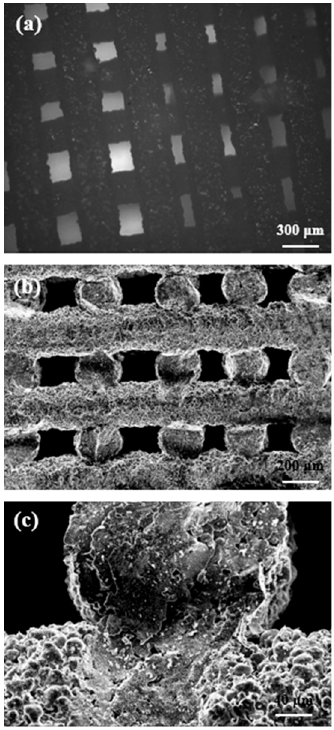
Figure 3. Morphological analysis of the scaffold: ( a ) top-view of the gradient of porosity and gird-like structure by optical microscopy; ( b ) SEM (scanning electron microscopy) cross-sectional image of the scaffold that was fractured to inspect the internal structure; ( c ) SEM micrograph of the trabecular section and joining region between adjacent filaments.